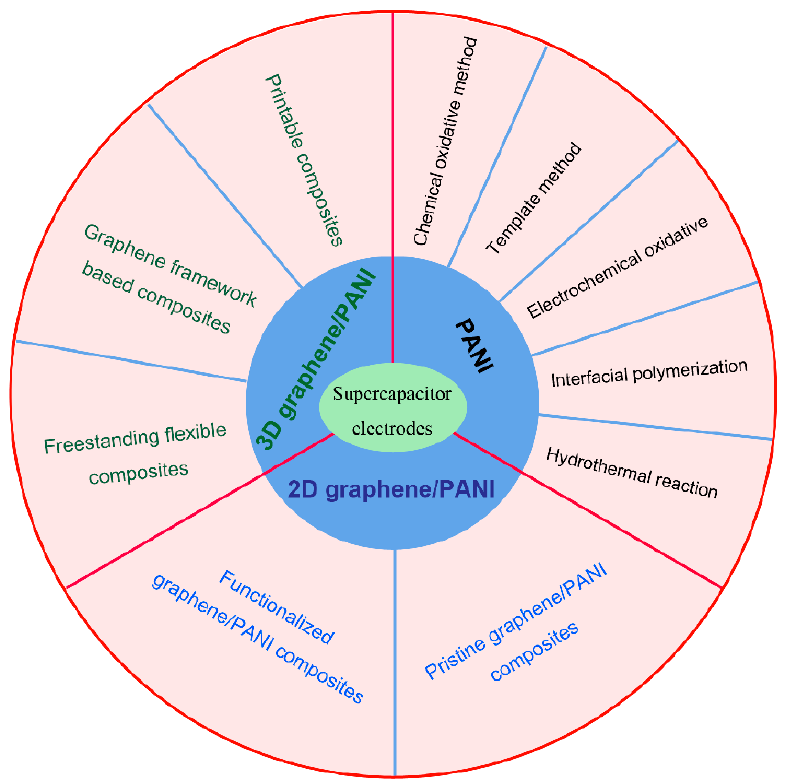
Figure 8. Schematic for preparing PANI, 2D and 3D graphene/PANI composites for supercapacitor electrodes.